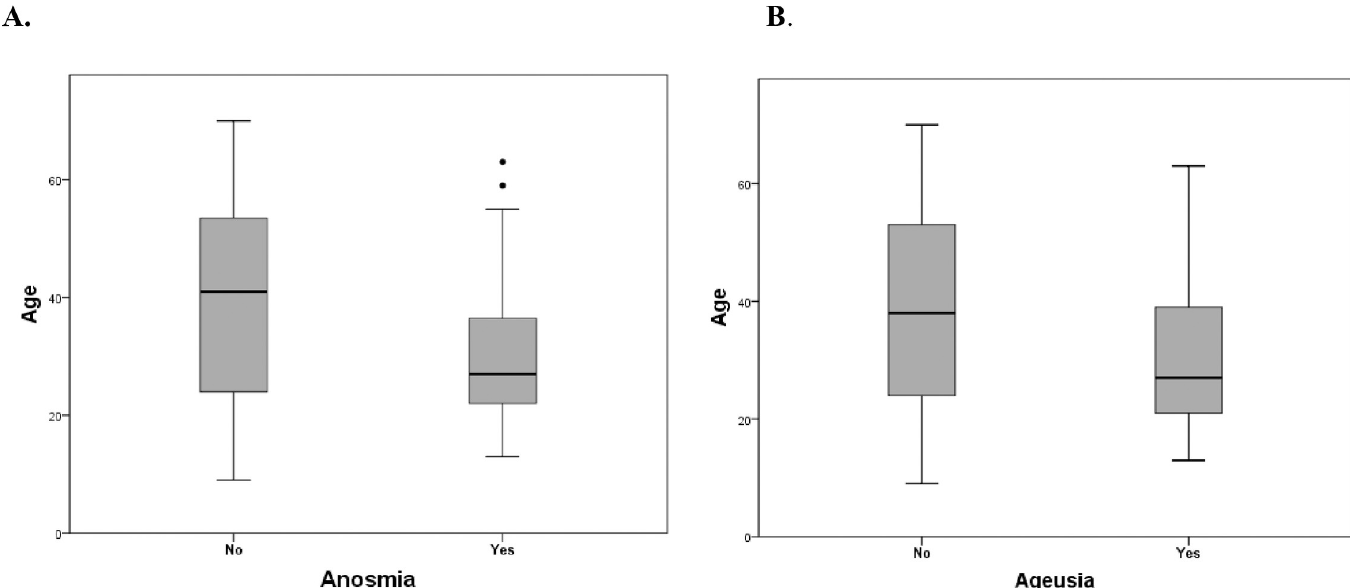
Fig 1. Distribution of age according to patients without or with symptoms. A . Patients with anosmia (n = 47), B. Patients with ageusia (n = 37).